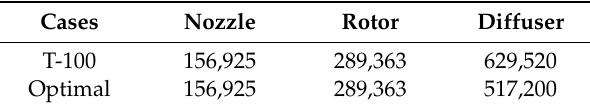
Figure 10. Computational mesh of the T-100. Table 4. Mesh statistic information.